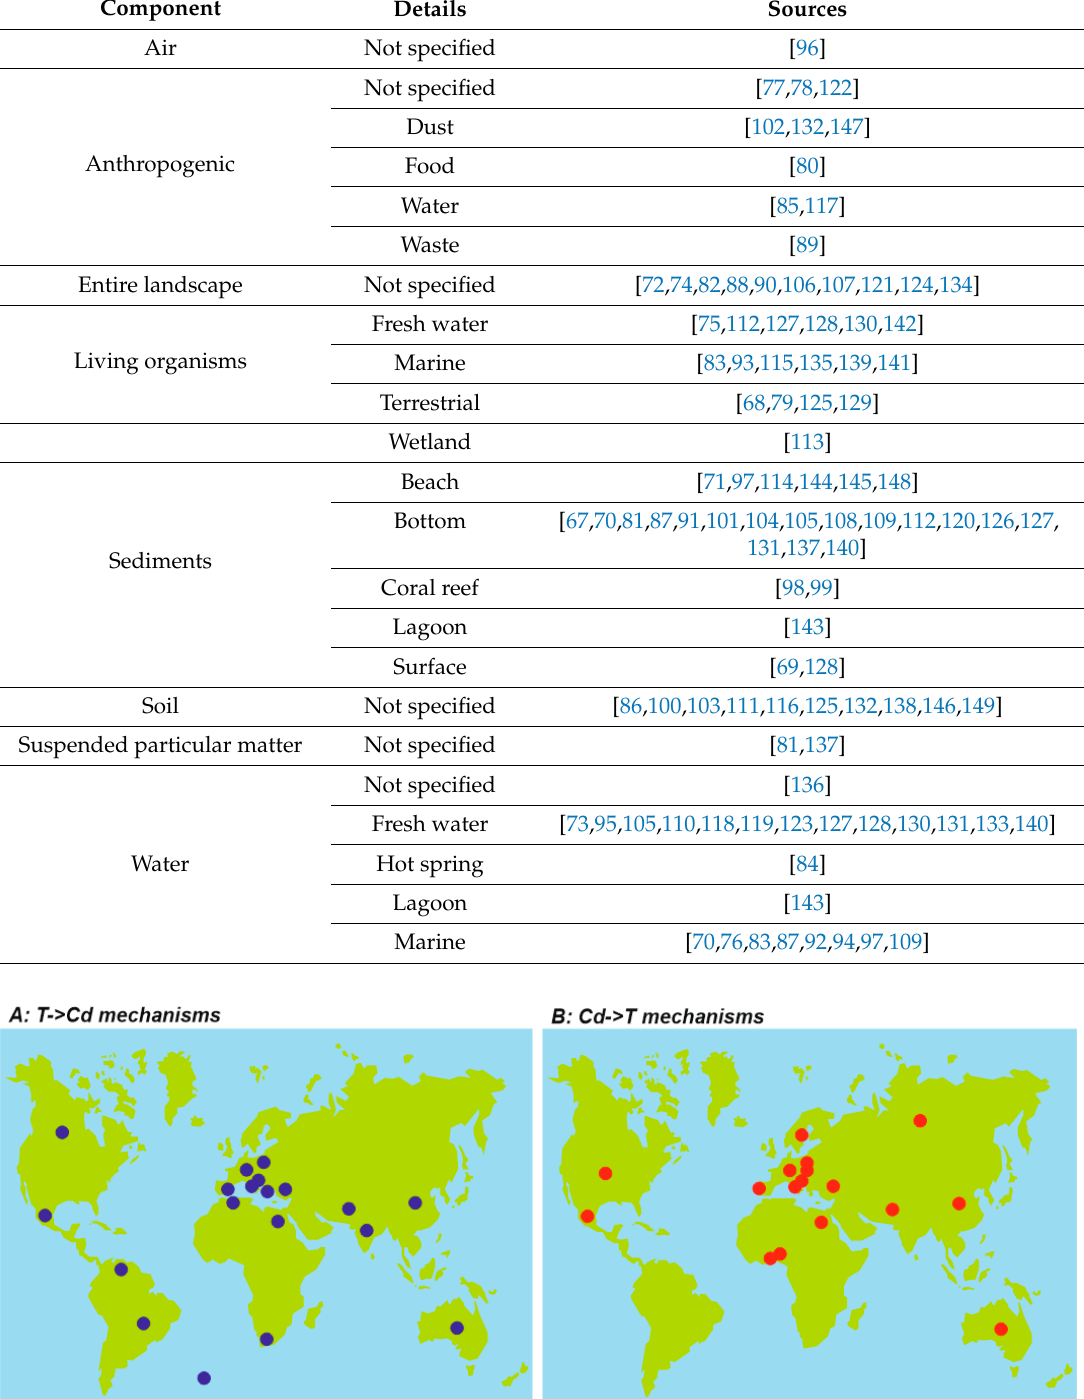
Figure 5. Examples of the contribution by tourism to Cd pollution ( A ) and Cd pollution creating risks to tourism ( B ). See Table 1 for to tourism ( B ). See Table 1 for data.